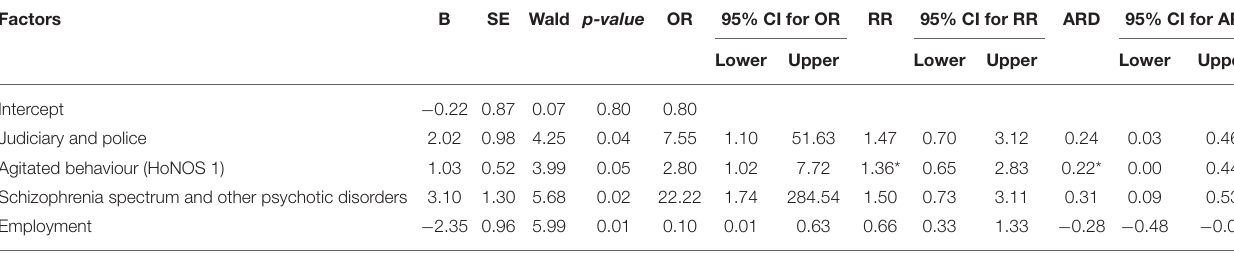
TABLE 3 | Potential predictors associated with hospitalisation during 6 weeks follow-up.